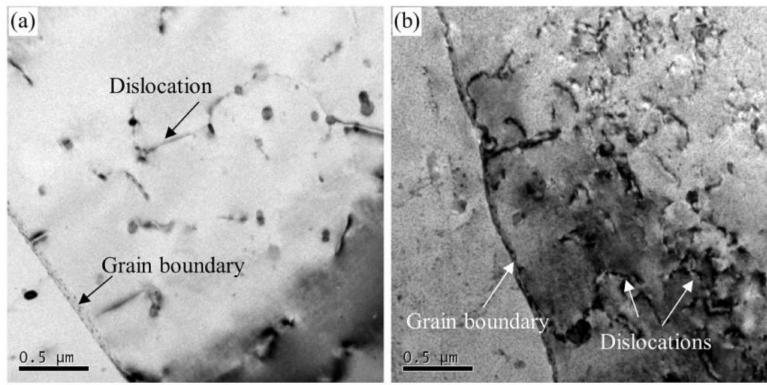
Figure 12. Dislocations micrographs of ( a ) under-aged alloy and ( b ) peak-aged alloy after 10 7 cycles